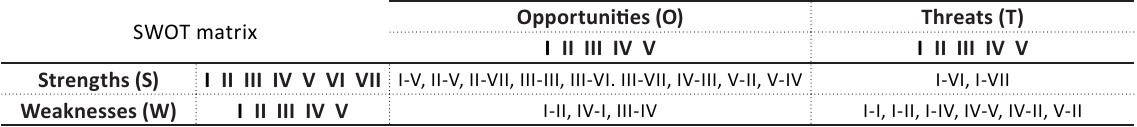
Table 6. SWOT analysis matrix for Sigma